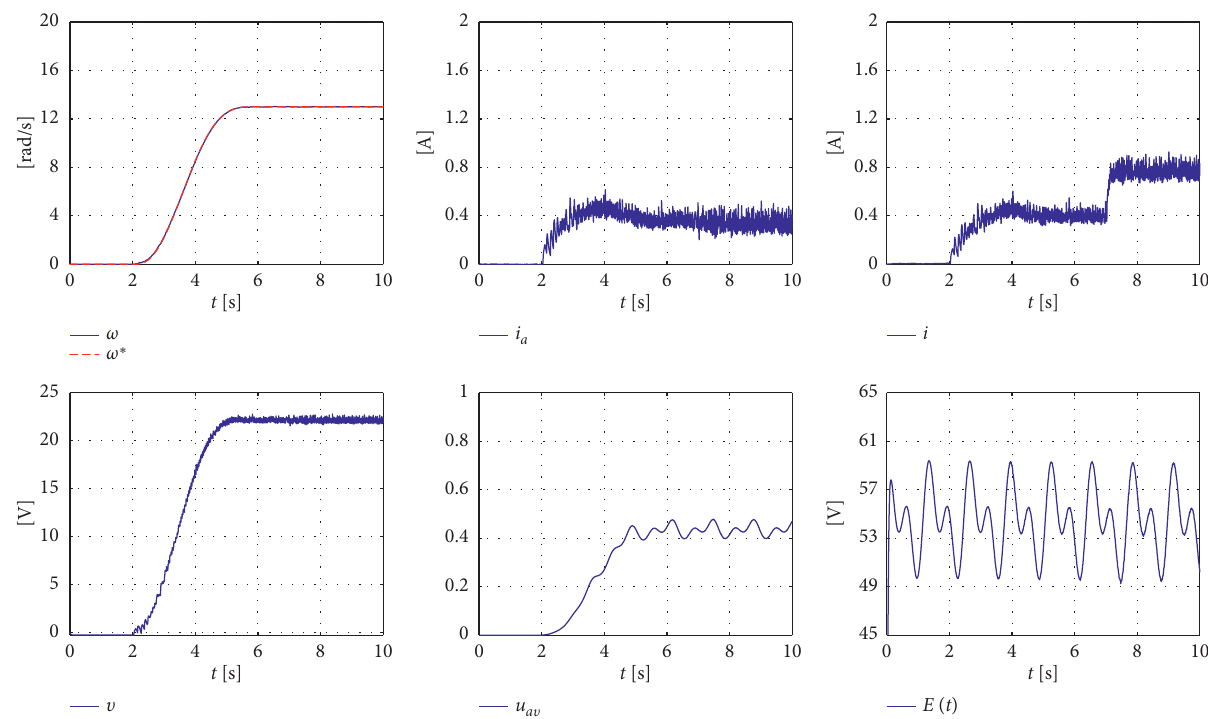
Figure 12: Dynamic response of the DC/DC Buck converter-DC motor system when E ( t ) , given by equation (24), is experimentally implemented through the TDK-Lambda G100-17 power supply and when the abrupt variations (equation (27)) are considered in R .